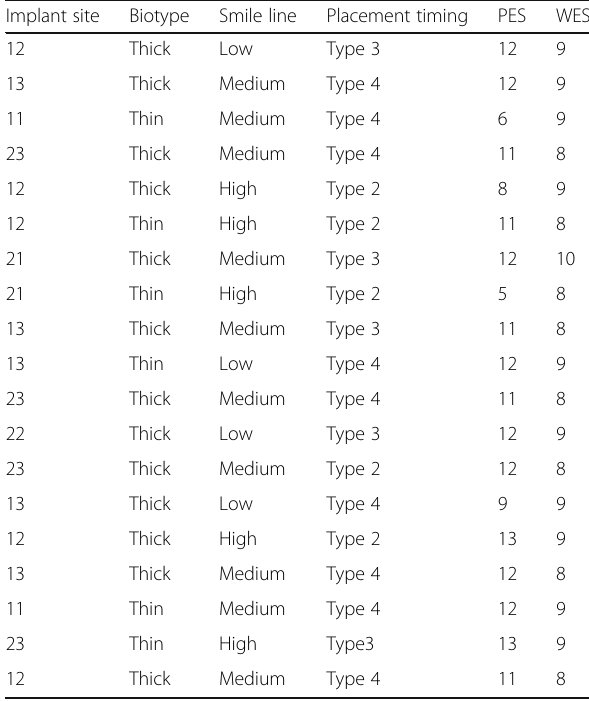
Table 1 Clinical features of the implants